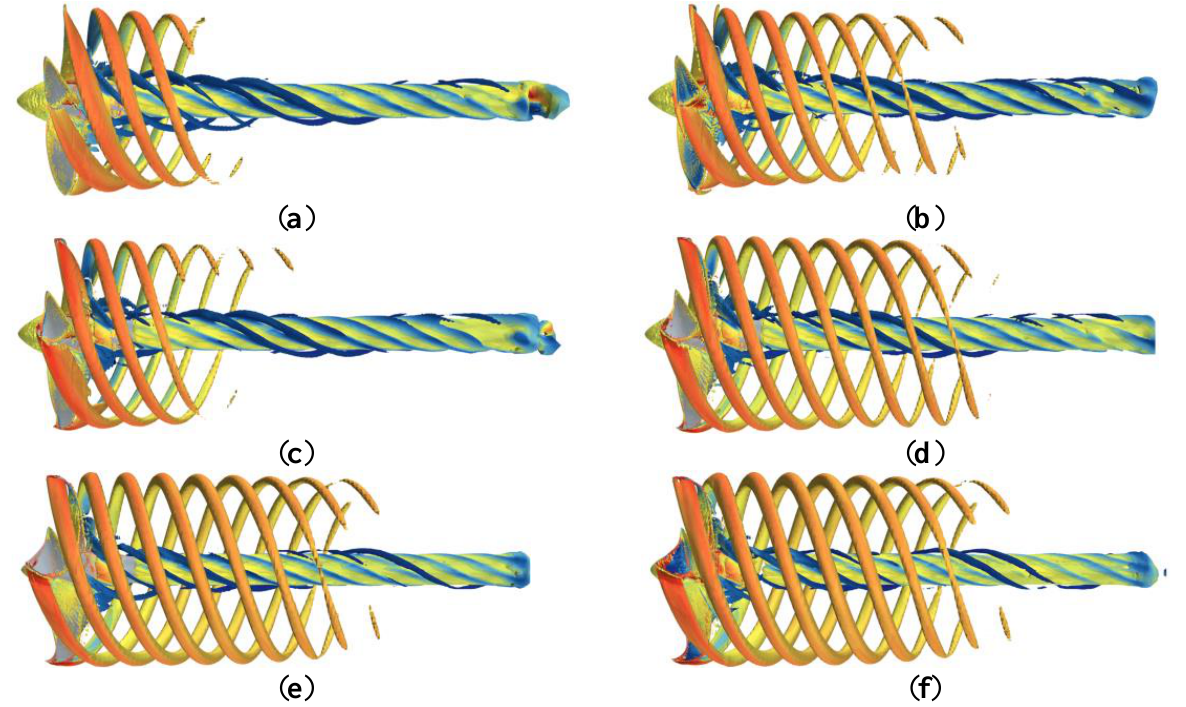
Figure 15. Visualization results of Kappel propeller vortex structures applying Q criteria for